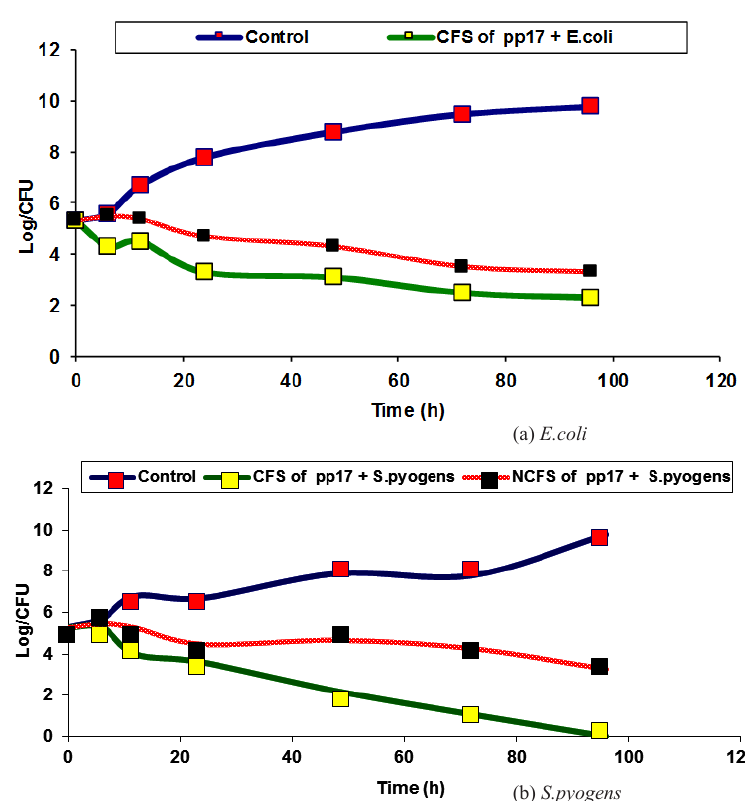
Fig. 5. Inhibitory effect of CFS and NCFS of PP17 against E.coli and